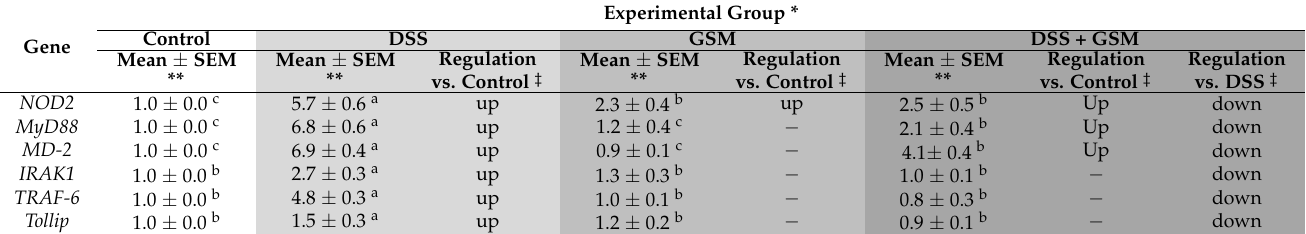
Table 3. The effects of GSM diet on the expression of TLRs signaling-associated genes in the colon of DSS-treated piglets.